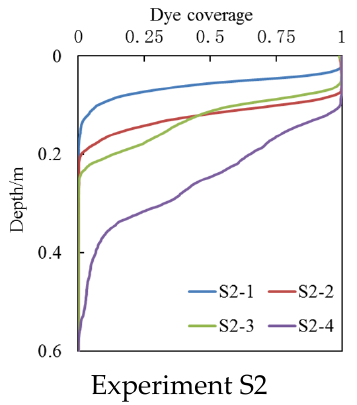
Experiment S3-6 Figure 7. Spatial distribution of infiltration depth under experiment S3. 3.2. Dye Coverage Establishing the dyeing area ratio is an intuitive and quantitative way of describing the trajectory of preferential flow in a vertical profile. By drawing different layers in the vertical direction, the three-dimensional spatial distribution of the preferential flow can be obtained [20]. In experiment S2, the average dyeing areas of the S2-1, S2-2, S2-3, and S2-4 treatments were 10.2%, 20.5%, 21.6%, and 41.7%, respectively. As can be seen from Figure 8, the average dyeing area ratio with different treatments decreased with the in- crease in the infiltration depth, indicating the infiltration process was not balanced and that there was a preferential flow phenomenon. The average dyeing area increased with the increase in rainfall intensity and rainfall duration. When the rainfall intensity was 20 mm/h, the average dyeing area decreased slowly with the increase in infiltration depth, and then, it decreased to zero rapidly. At this point, only a small part of the preferential flow was developed, and the soil water infiltration was mainly dominated by matrix flow.